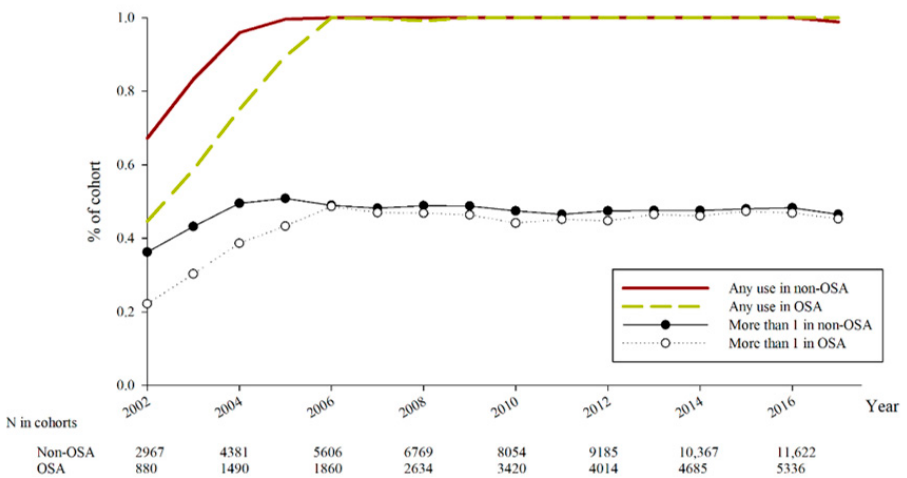
Figure 3. The number of anti-glaucomatous medications in every year between obstructive sleep apnea group and control group. N: number, OSA: obstructive sleep apnea.